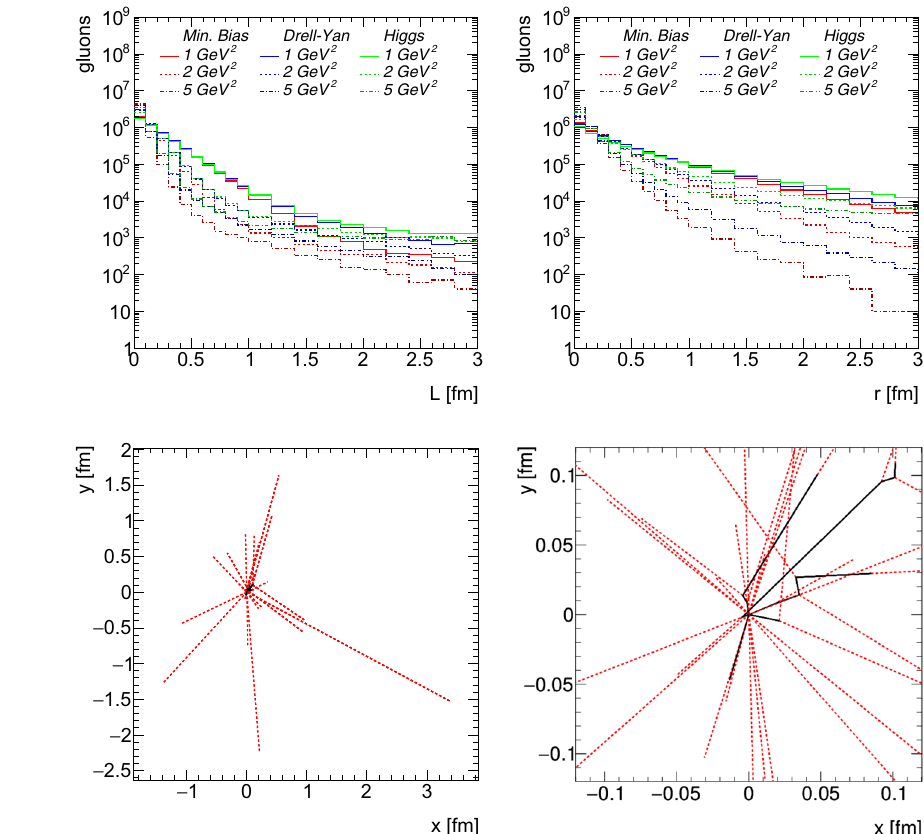
Fig. 3 The total Lorentz-invariant distance L (left panel) and transverse distance r (right panel) traveled by the gluons at the last step of the parton shower evolution for three different processes: minimum bias, Drell–Yan and Higgs-boson production at the LHC at the centre-of-mass energy 7 TeV. The simulation was performed using default version of Herwig 7 using three different values of ν 2 : 1, 2 and 5 GeV 2